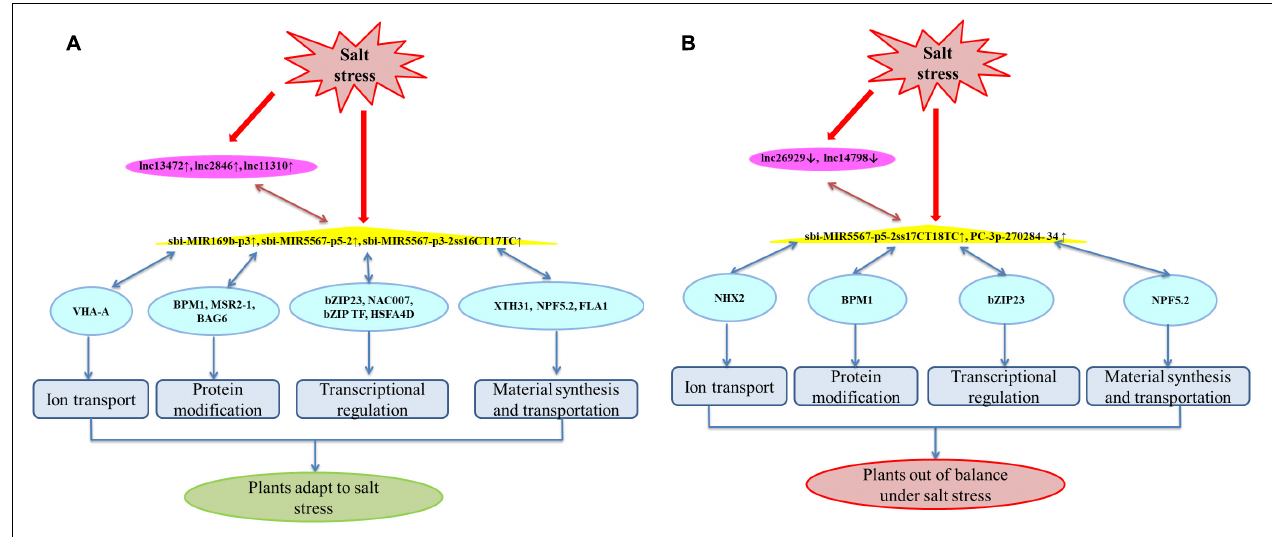
FIGURE 7 | A hypothetical model for ceRNA regulatory networks in M-81E (A) and Roma (B) . Pink, yellow, and blue nodes represent lncRNAs, miRNAs, and mRNAs, respectively. Blue edges represent miRNA-target interactions, pink edges represent a competitive